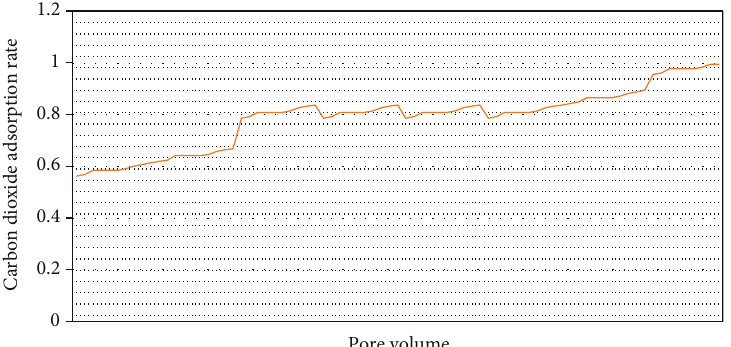
Figure 4: Representation of the data statistics for the input CO the dataset in [7, 8]).